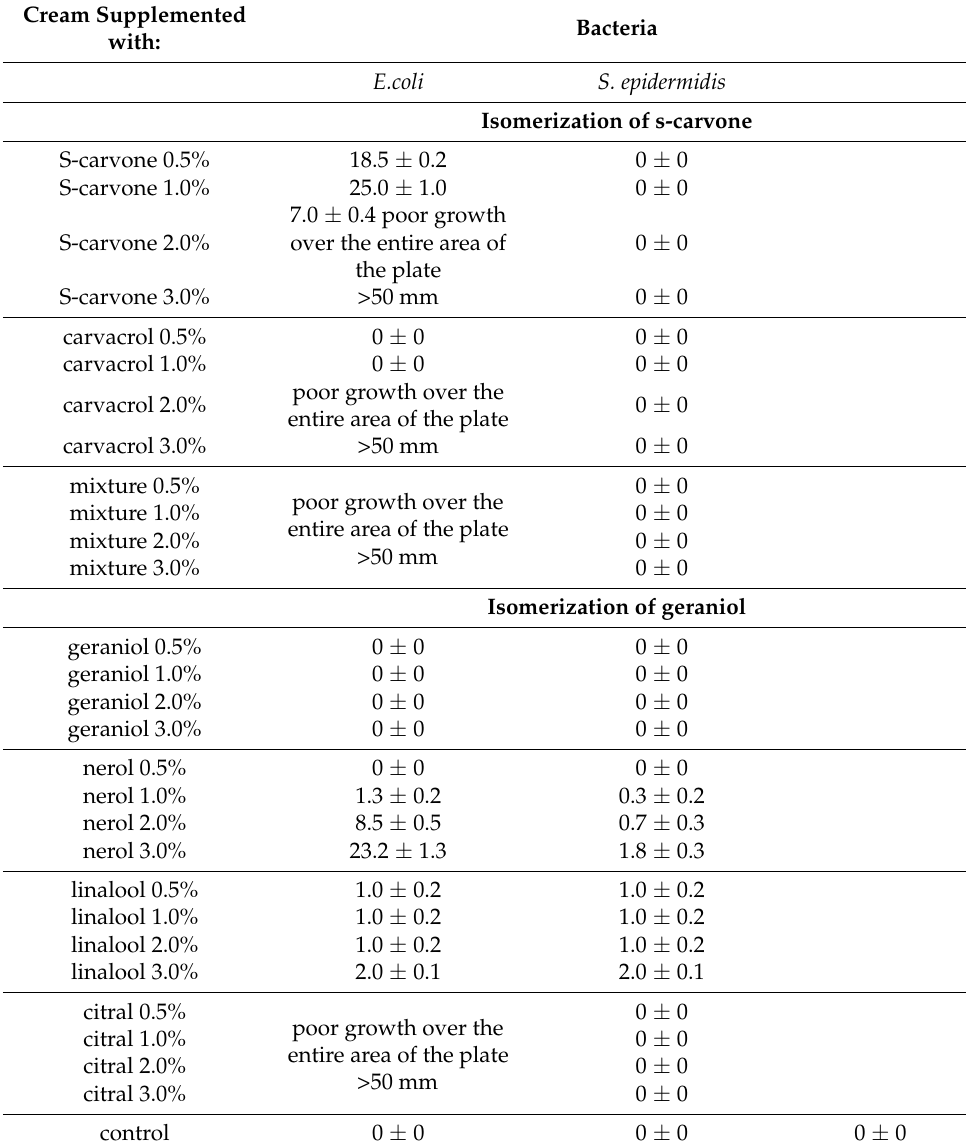
Table 2. Antibacterial test of creams containing Ss-carvone, geraniol, and derivatives. Cream Supplemented